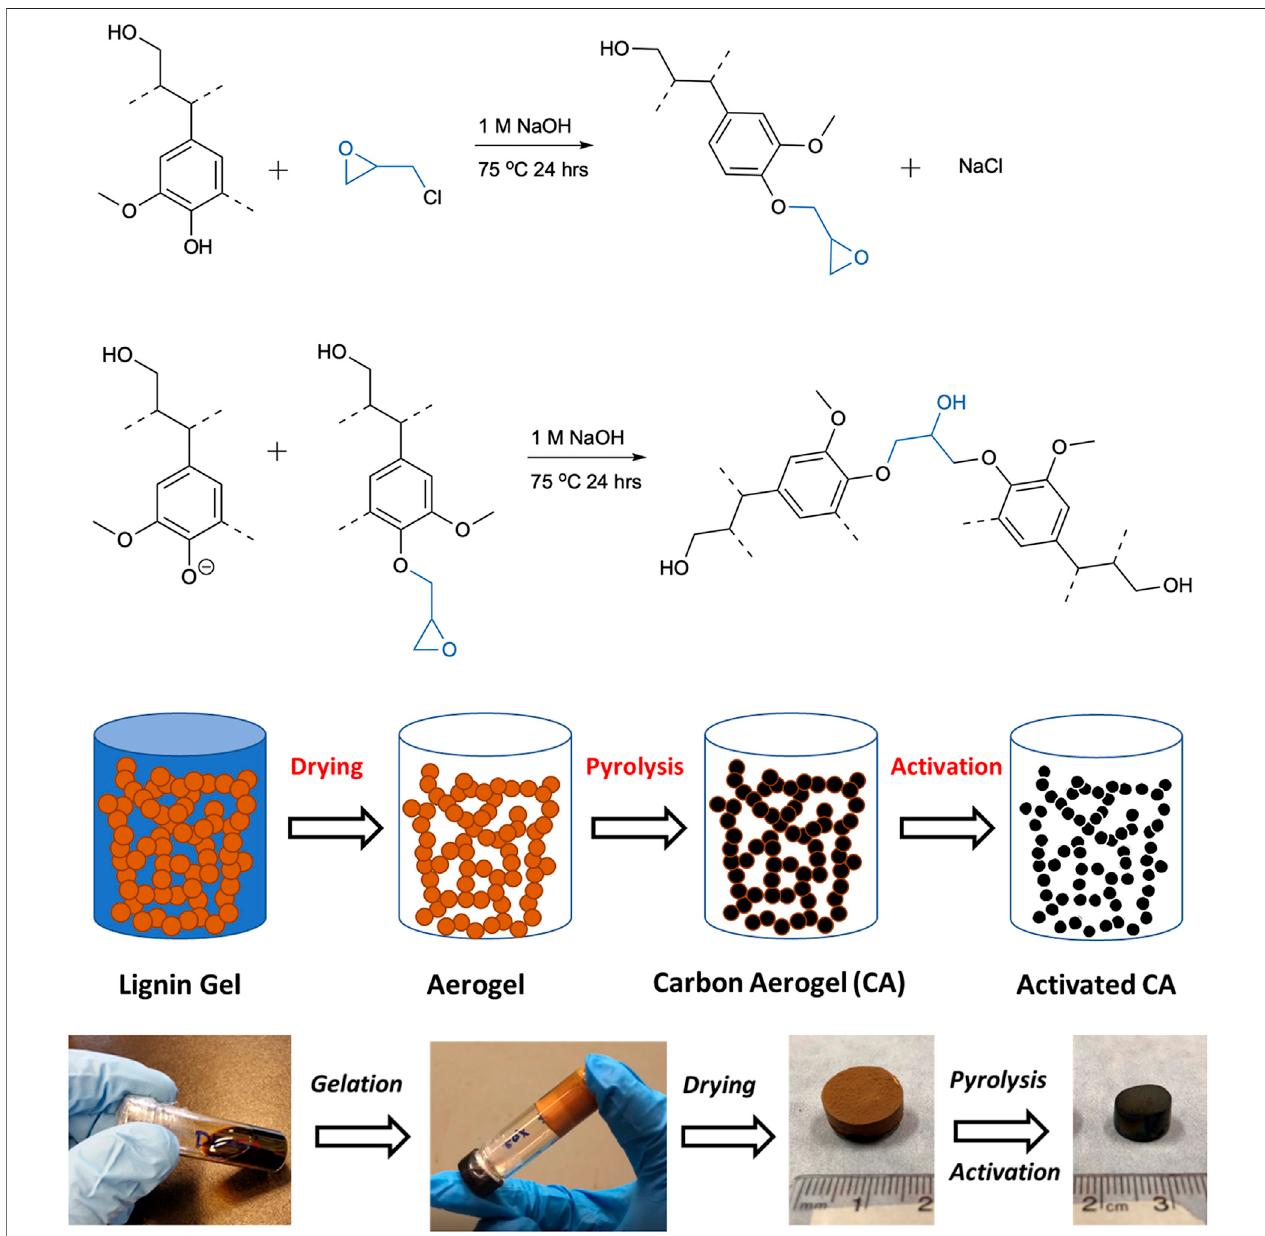
FIGURE 1 | Possible reaction mechanism between lignin and epichlorohydrin; epoxidation of hydroxyl groups of lignin followed by formation of crosslinks. A schematic of the processing steps and preparation of lignin carbon aerogels.